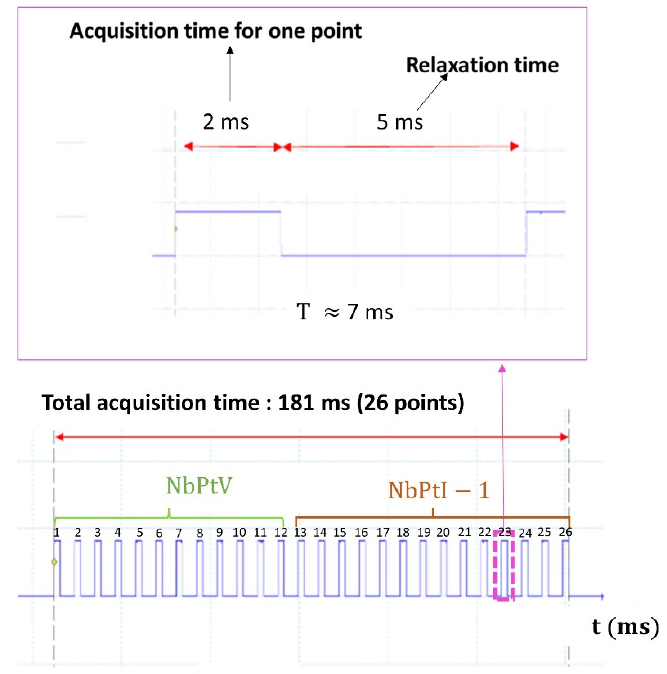
Figure 4. Acquisition time.